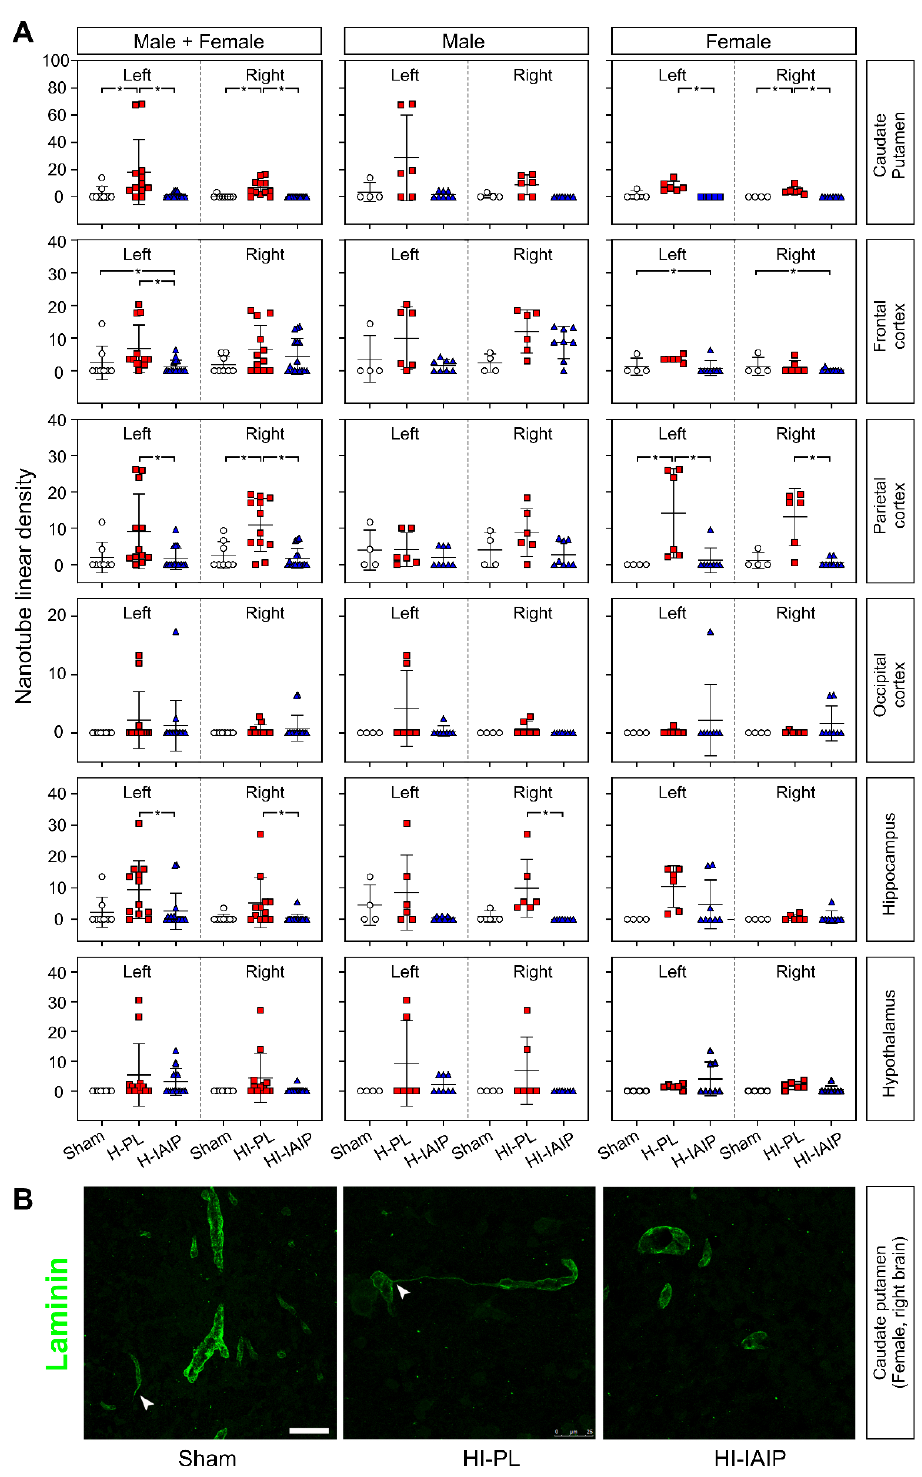
Figure 3. The effects of systemic treatment with IAIPs on TNT linear density in neonatal rats after exposure to systemic hypoxia and hypoxia–ischemia. ( A ) Quantification of cumulative TNT linear density in the experimental groups in the selected regions of the left and right hemispheres and total group of males + females and separately for the males and females. Data are mean ± SD. Male: sham = 4, H - PL/HI - PL = 6, H - IAIP/HI - IAIP = 8. Female: sham = 4, H - PL/HI - PL = 6, H - IAIP/HI - IAIP = 8. * p ≤ 0.05 for indicated comparisons. ( B ) Representative confocal microscopic images of laminin im- munostained HI - right caudate – putamen in the female neonatal rats, showing the presence of TNTs connecting two microvessels (arrowhead, HI - PL). In sham - treated and HI - IAIP - treated brains, these angiogenic features are rarely detected (arrowhead, sham). Scale bar: 25 µm.